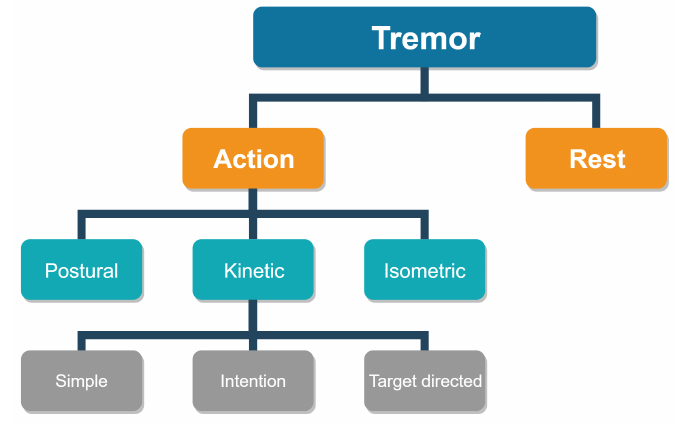
Figure 1. Basic division of